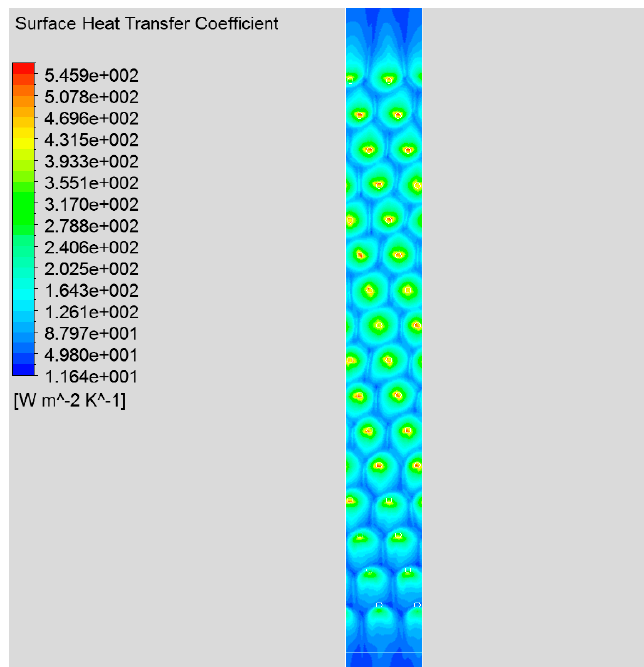
Figure 20. Distribution of the coefficient with convective thermal exchange along the band.